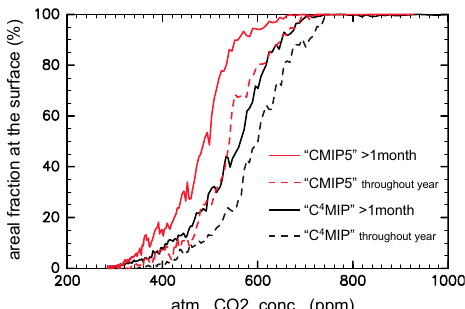
Fig. 6. The evolution of the areal fraction of undersaturated surface water with atmospheric CO 2 concentration for “C 4 MIP” (black) and “CMIP5” (red) model versions. The solid and dashed lines represent evolution in at least one month of the year and throughout the year, respectively.